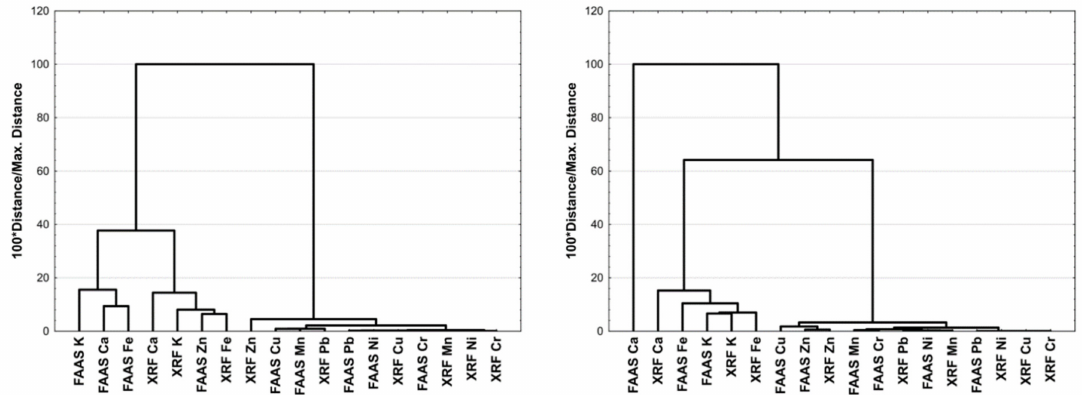
Figure 6. Dendrograms of the elemental composition of PM10 in relation to the analytical method EDXRF and AAS (winter on the left and spring on the